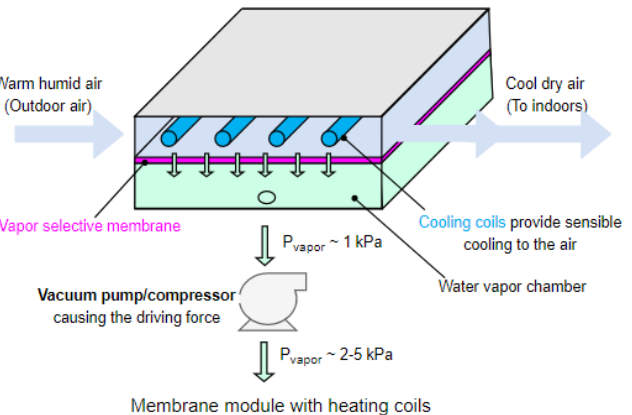
Figure 1. Membrane energy exchanger design. This design simultaneously cools the warm humid air while dehumidifying it with the membrane, helping to avoid the high energy consumption associated with the condensation of water vapor.